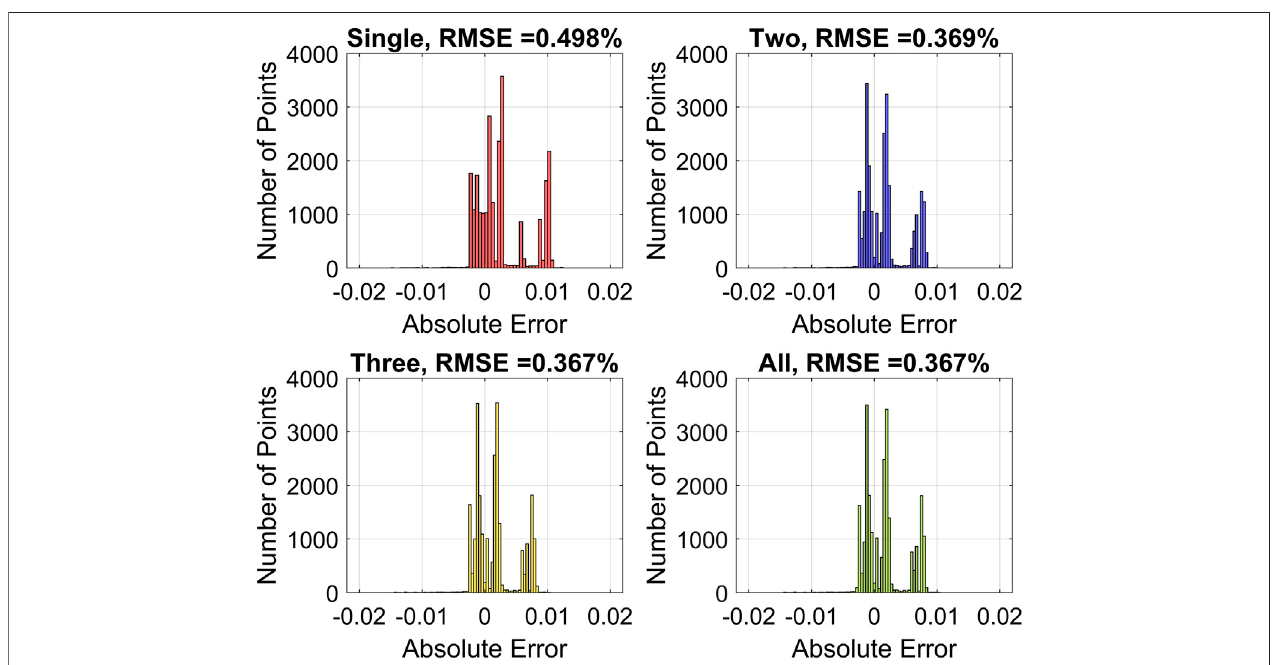
FIGURE 16 | Histograms of intake manifold burnt gas mass fraction estimation error when using optimal sensor sets.